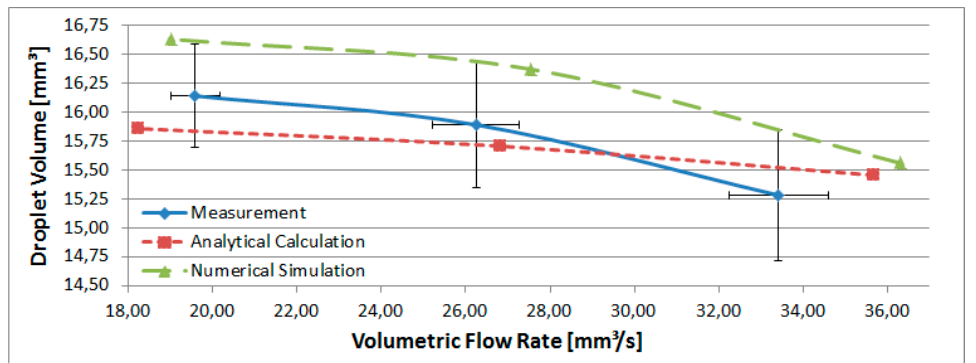
Figure 3. This figure shows the droplet volume depending on the volumetric flow rate into the droplet: The droplet volume increases with decreasing volumetric flow rate.